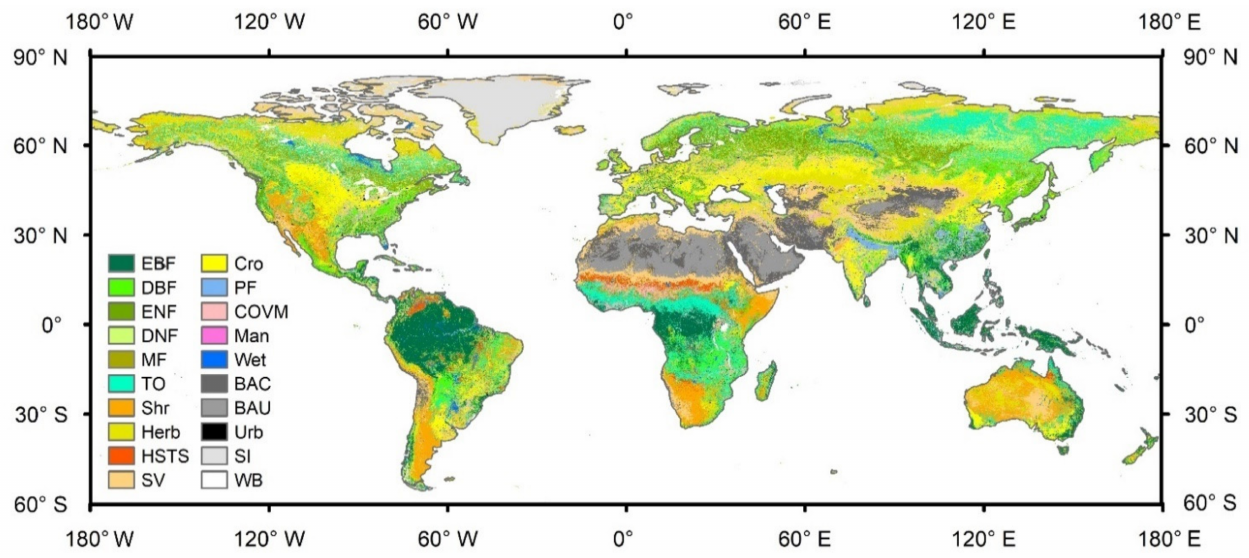
Figure 2. The global land cover map in 2013 at 500 m resolution. (1) EBF: Broadleaf Evergreen Forest; (2) DBF: Broadleaf Deciduous Forest; (3) ENF: Needleleaf Evergreen Forest; (4) DNF: Needleleaf Deciduous Forest; (5) MF: Mixed Forest; (6) TO: Tree Open; (7) Shr: Shrub; (8) Herb: Herbaceous; (9) HSTS: Herbaceous with Sparse Tree/Shrub; (10) SV: Sparse vegetation; (11) Cro: Cropland; (12) PF: Paddy field; (13) COVM: Cropland and Other Vegetation Mosaic; (14) Man: Mangrove; (15) Wet: Wetland; (16) BAC: Bare area, consolidated (gravel and rock); (17) BAU: Bare area, unconsolidated (sand); (18) Urb: Urban; (19) SI: Snow or Ice; (20) WB: Water